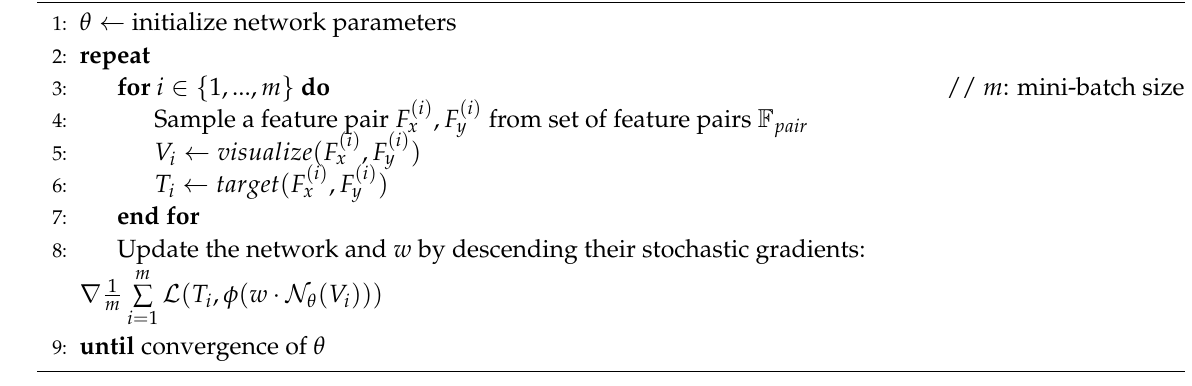
Algorithm 1 Dependence representation learning.